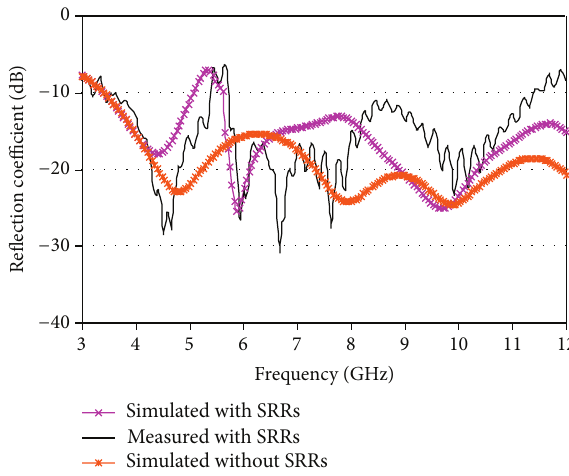
Figure 6: Measured and simulation reflection coefficient.